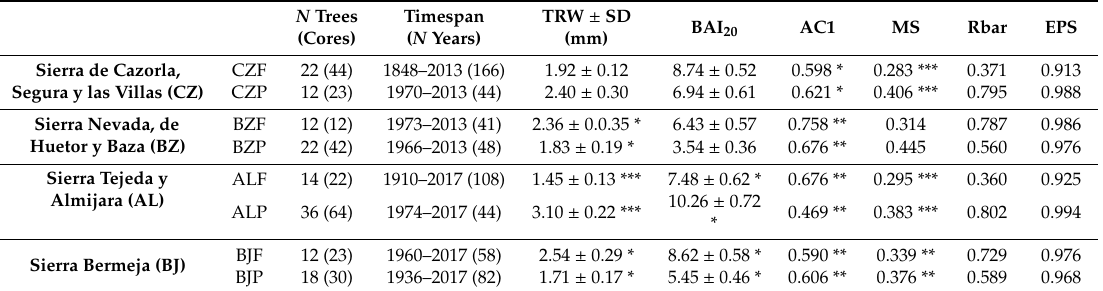
Table 2. Dendrochronological statistics of Pinus pinaster sites sampled in natural forests (F) or plantations (P) within Andalusia. Abbreviations: TRW, mean tree-ring width; BAI20, mean basal area increment in the last 20 years (mean ± SD); MS, mean sensitivity; Rbar, mean correlation between trees; site codes are shown in Table 1. Values are means ± SE. Di ff erent levels of significance are shown for the Student’s t-test between stand type: * 0.05 < p ≤ 0.10; ** 0.01 < p ≤ 0.05; *** p ≤